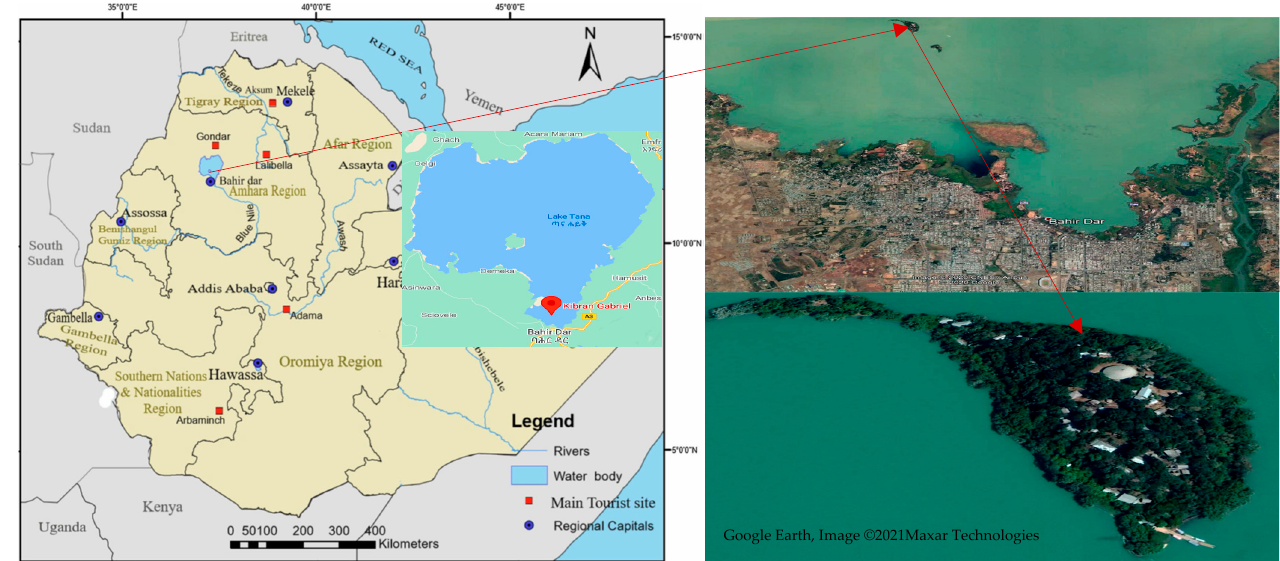
Figure 2. Geographic location of Kibran Gabriel island.